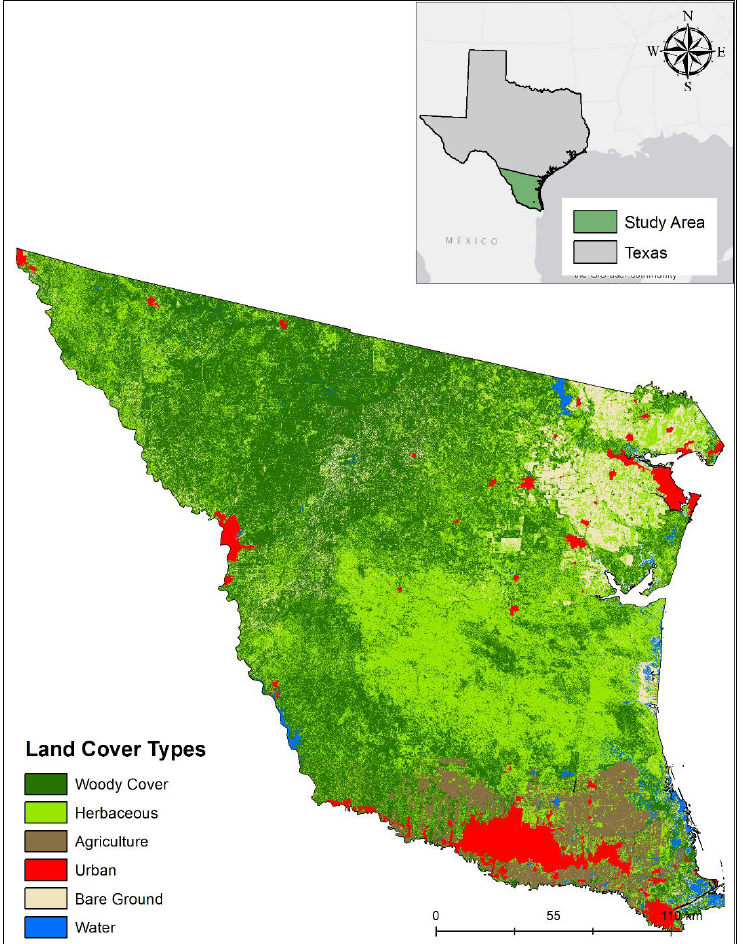
Figure 1. The study area for woody cover landscape suitability model for endangered ocelots in southern Texas.